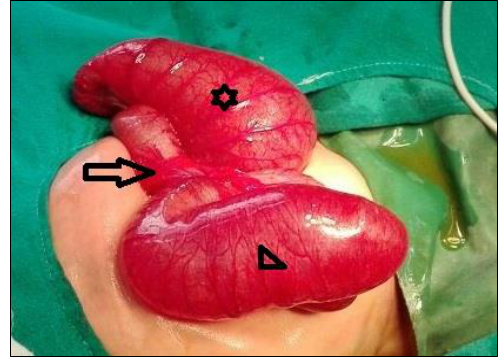
Figure 2: Showing operative finding. Star showed CPC and triangle showed proximal segmental dilatation. Arrow showed normal intervening